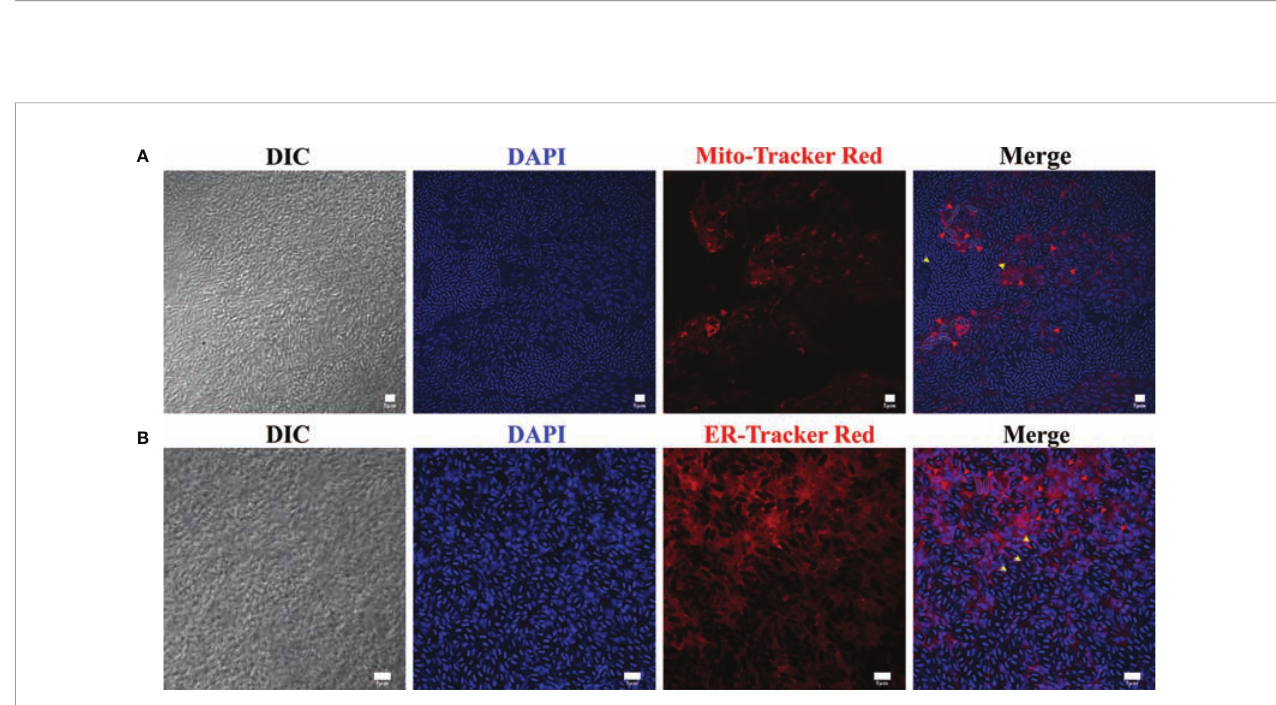
FIGURE 4 | The observation of xenoma nucleus. The nucleus (arrowhead) of xenoma and V. necatrix BM were stained with DAPI (blue). The hypertrophied nucleus was labeled with a dashed line. Bar, 10 µm.